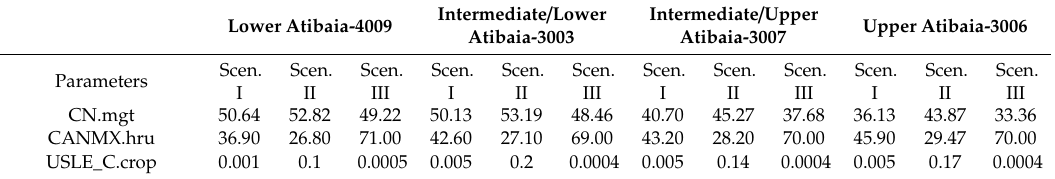
Table 3. Calibrated curve number (CN), maximum canopy storage for each land use (CANMX) and cover and management factor (USLE_C) average values related for each sub-basin.